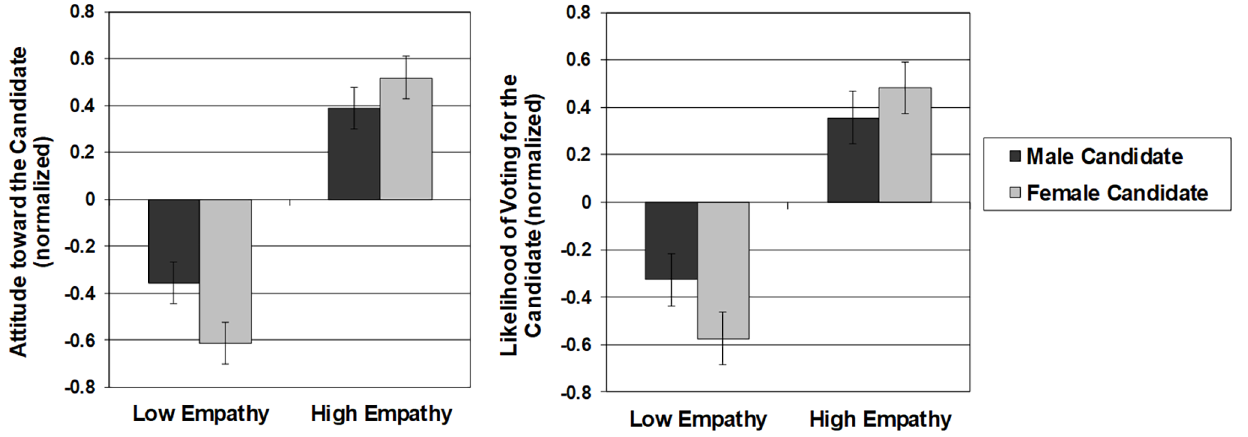
Figure 1. Two-way interactions between candidate gender and displays of empathy by the candidate on attitudes toward the candidate and likelihood of voting for the candidate (Study